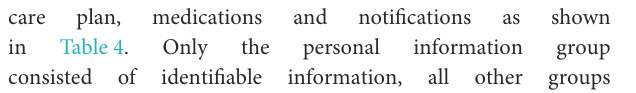
care plan, medications and notifications as shown were linked with the personal information using Only the personal information group consisted of identifiable information, all other groups